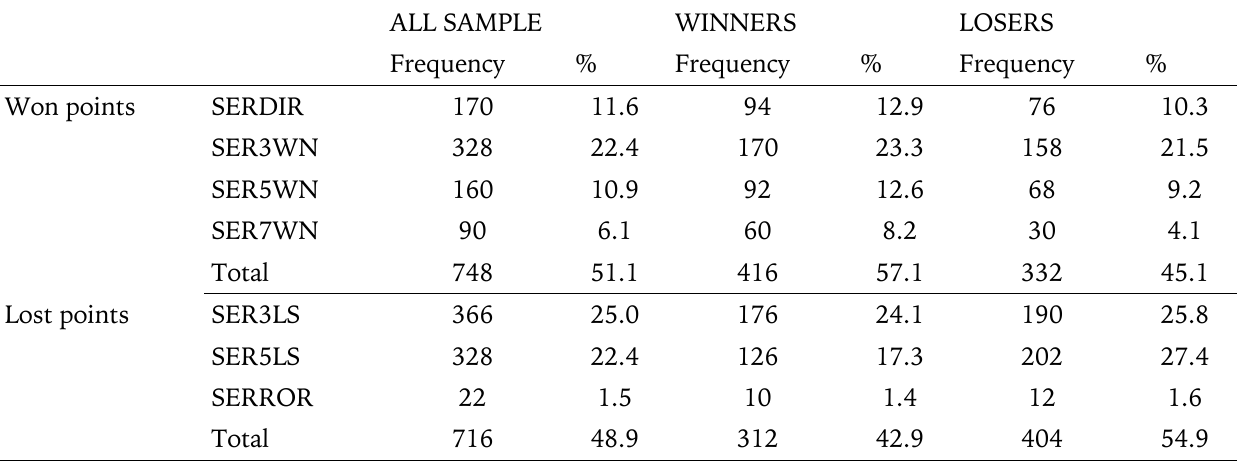
Results of analysis of serve outcome of all sample and according result outcome (winners/losers) ALL SAMPLE